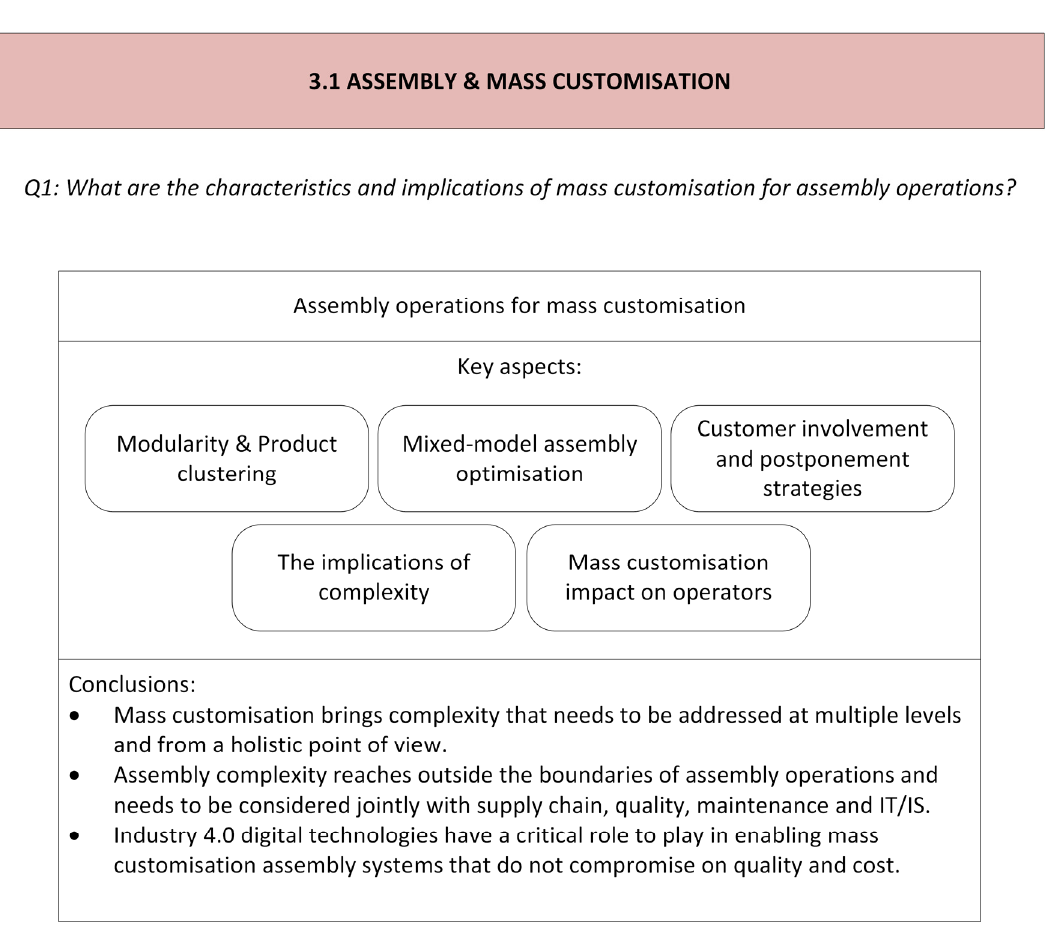
Figure 5. Key aspects of assembly operations for mass customization and main conclusions of the